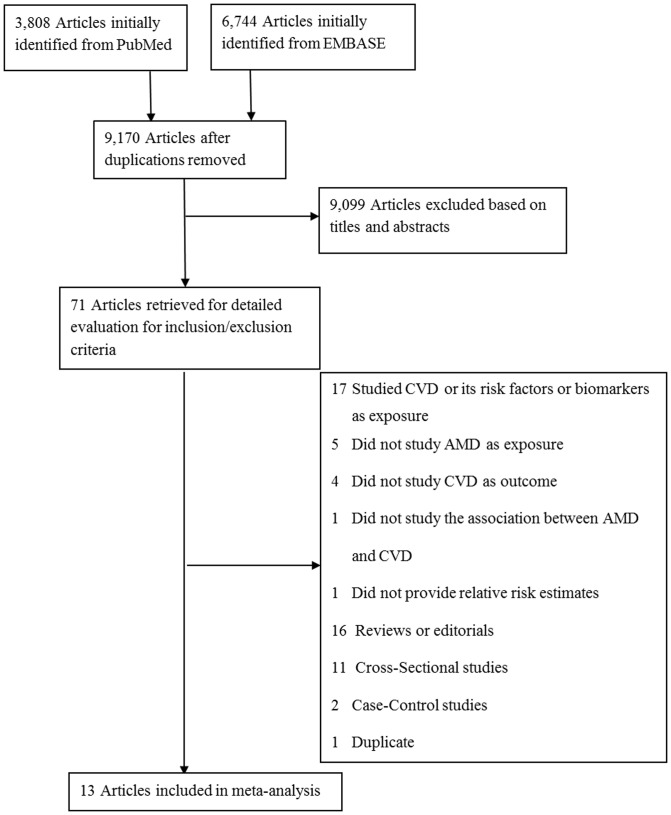
Flowchart of literature search for meta-analysis.None.